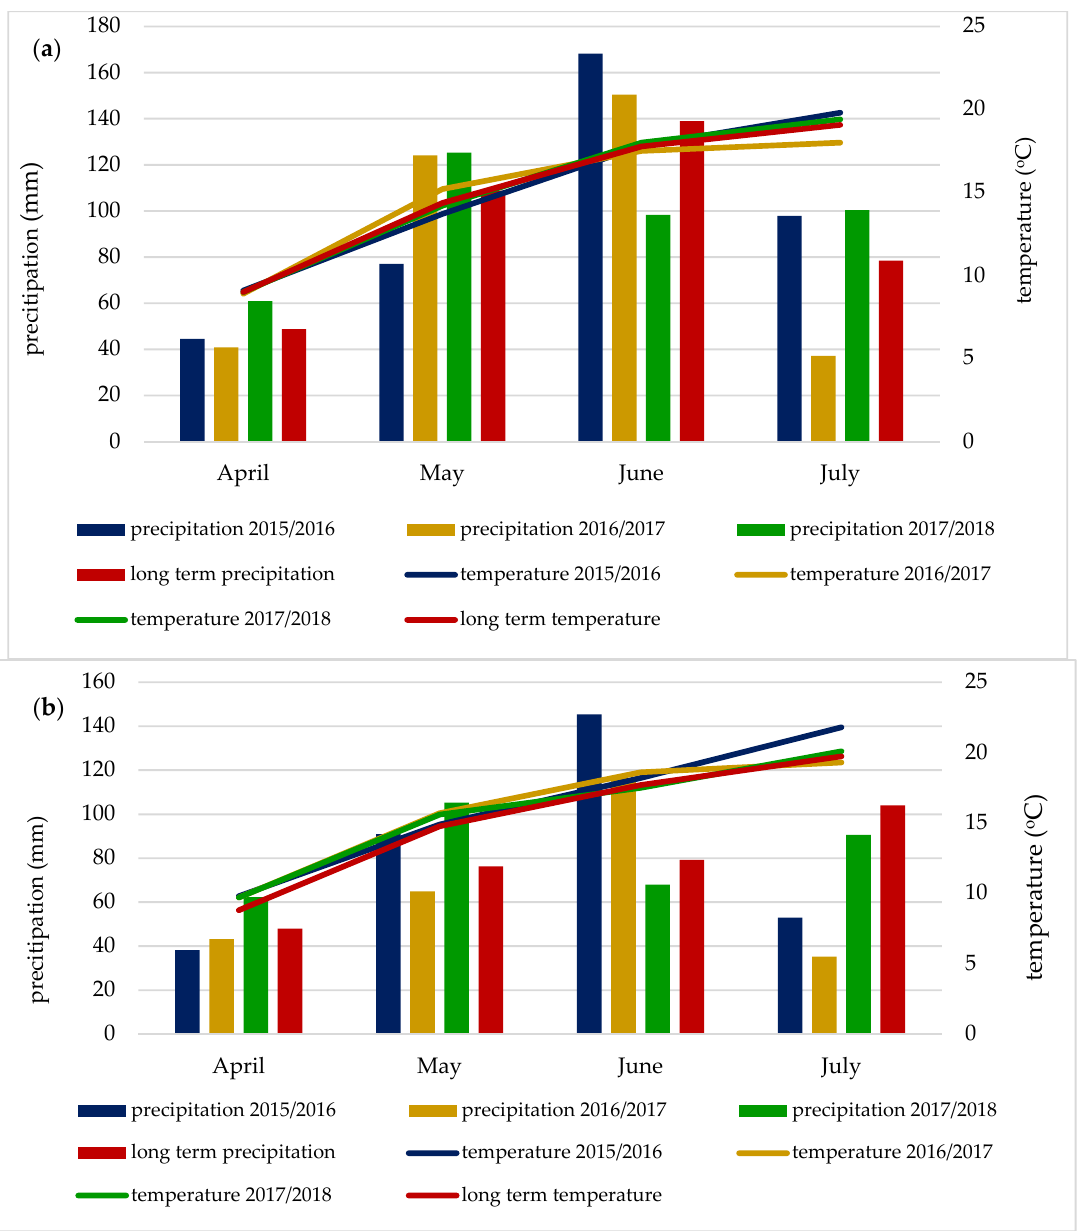
Figure 1. Weather conditions during the spring–summer growing season of wheat in two locations ( a ) Dukla; ( b ) Nowy Lubliniec.